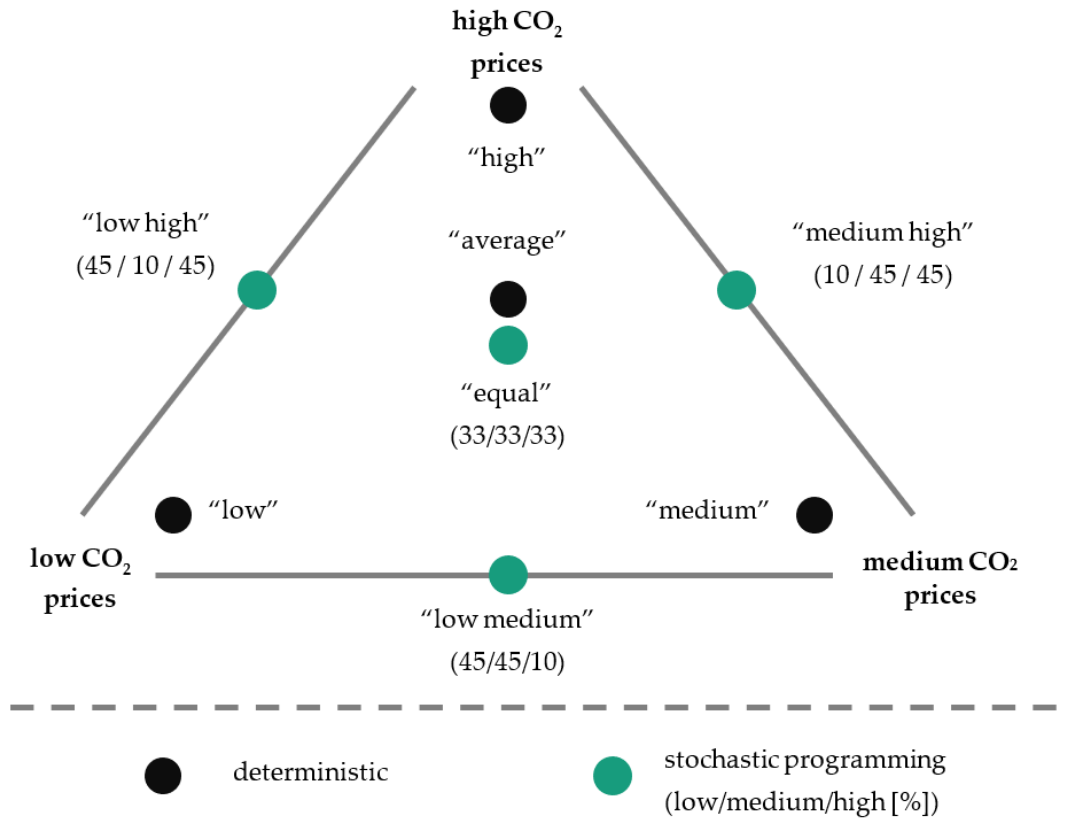
Figure 3. Defined scenarios with uncertain CO 2 prices.